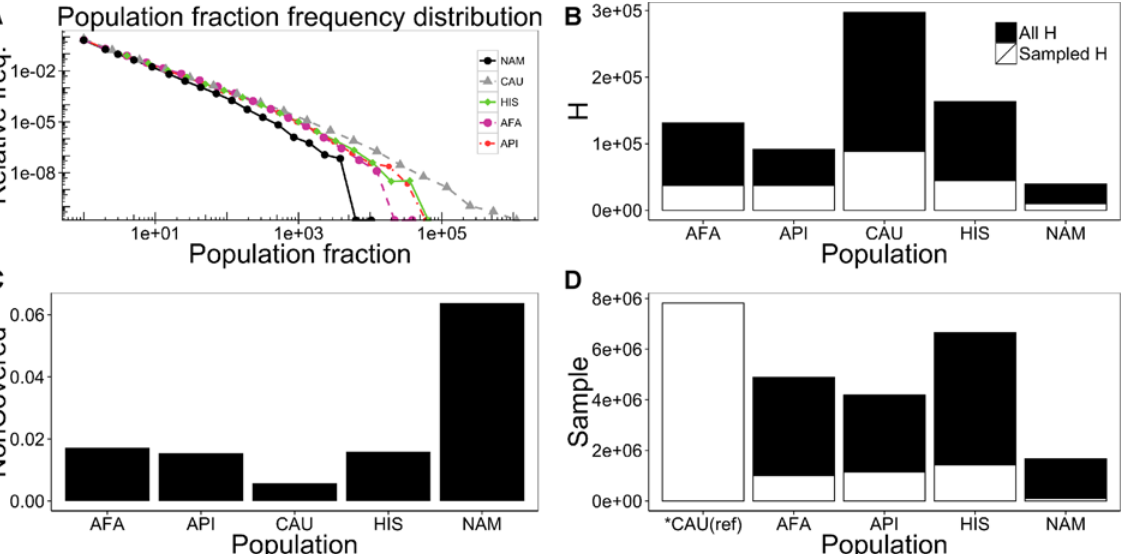
Fig 5. Properties for haplotypes frequency distribution for 5 populations : Native Americans (NAM), European Americans (CAU), Hispanic (HIS), African-Americans (AFA) and Asian Pacific Islanders (API). (A) Histogram of haplotype relative frequency distribution for the five combined populations: Native Americans (NAM, black circles), European Americans (CAU, gray triangles), Hispanic (HIS, green diamonds), African-Americans (AFA, purple circles) and Asian Pacific Islanders (API, red circles). (B) Estimated (black) and currently observed (white) total number of haplotypes. (C) Fraction of non- covered population for the five combined populations. (D) Current sample size (white) and estimated sample size required to get coverage similar to the European American population (black) for the five combined populations. Note that if the fit to a truncated power law would be precise, the required and observed population size would be precisely equal for the Caucasian population. However, there are some limited deviations in the fit, and the required population from the theoretical analysis is 7.76E+06, while the observed population size is 7.82E6 (a difference of less than 1%).